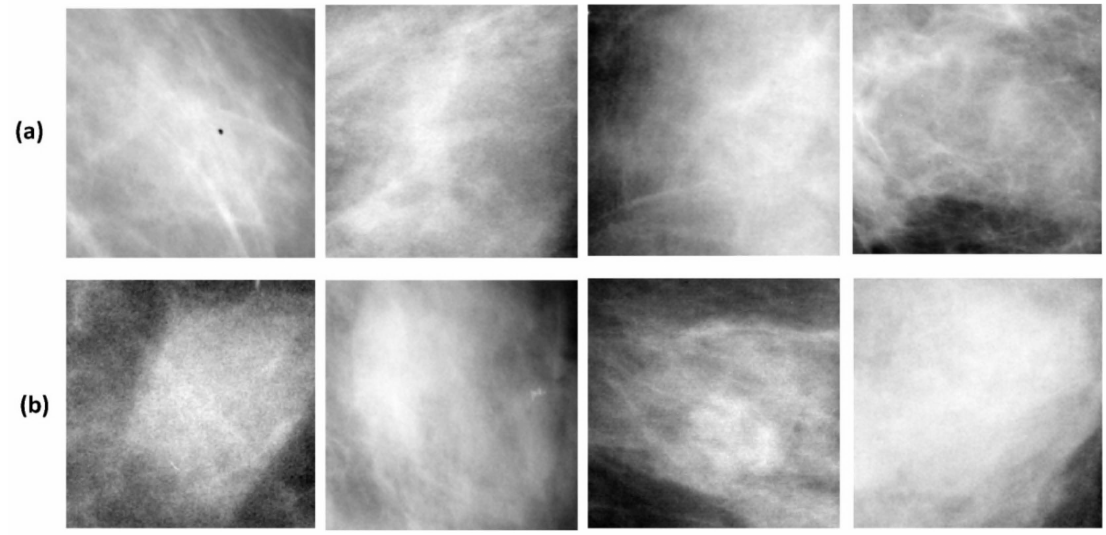
Figure 16. Example of mass regions, which are in dense surroundings, and it is difficult for the models to predict them correctly; ( a ) benign mass that is misclassified as a malignant mass; ( b ) malignant mass that is misclassified as a benign